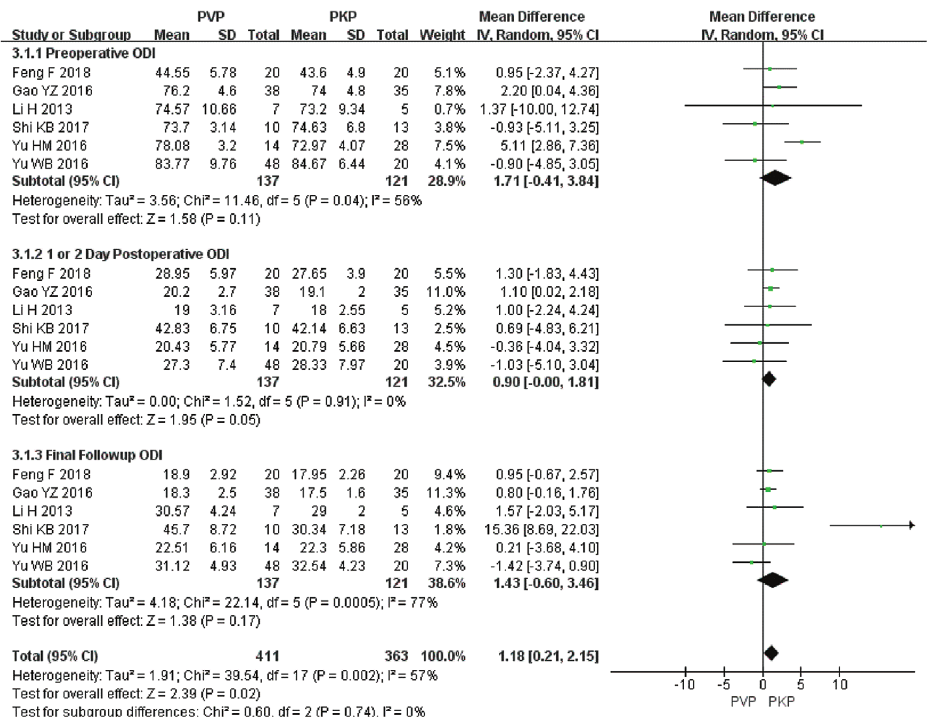
Figure 4. Forest plot to assess ODI between the two procedures.